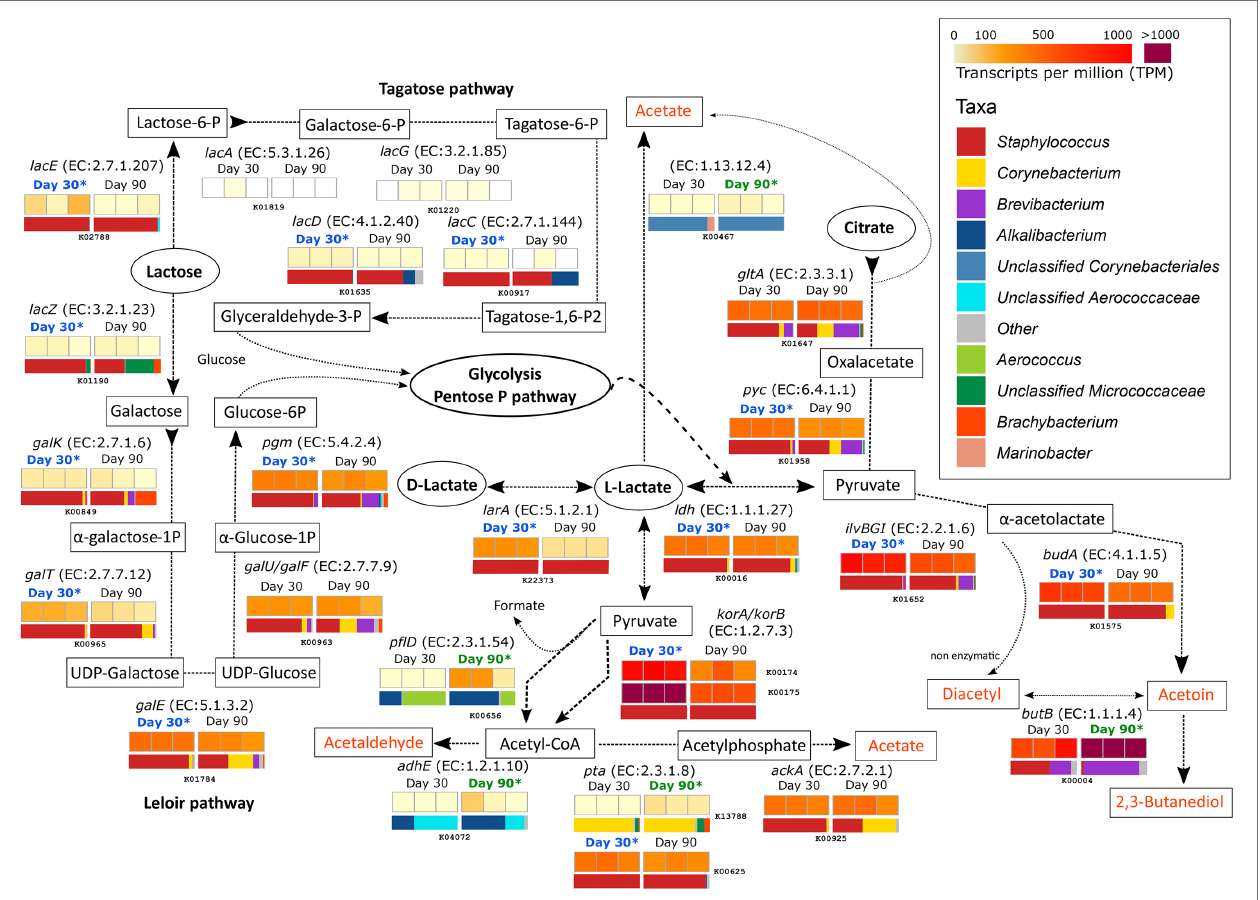
FIGURE 2 | Metabolism of residual lactose, lactate and citrate. The different compounds that are generated in each metabolic pathway are showed and those harboring important organoleptic properties for cheese are colored in orange. The different metabolic pathways can be followed according to the corresponding arrows. Between every pair of compounds, the enzyme that catalyzes each reaction is listed (gene name and EC number). Below each enzyme are six squares showing the TPM values for each of the six different samples. The TPM color scale appears in the legend in the upper-right part of the figure. Above the TPM values, the ripening time is highlighted if significant differences occur in the transcription of that gene in that ripening time ( p < 0.05). The horizontal bar-plot below the TPM values correspond to the percentage of transcripts assigned to the different